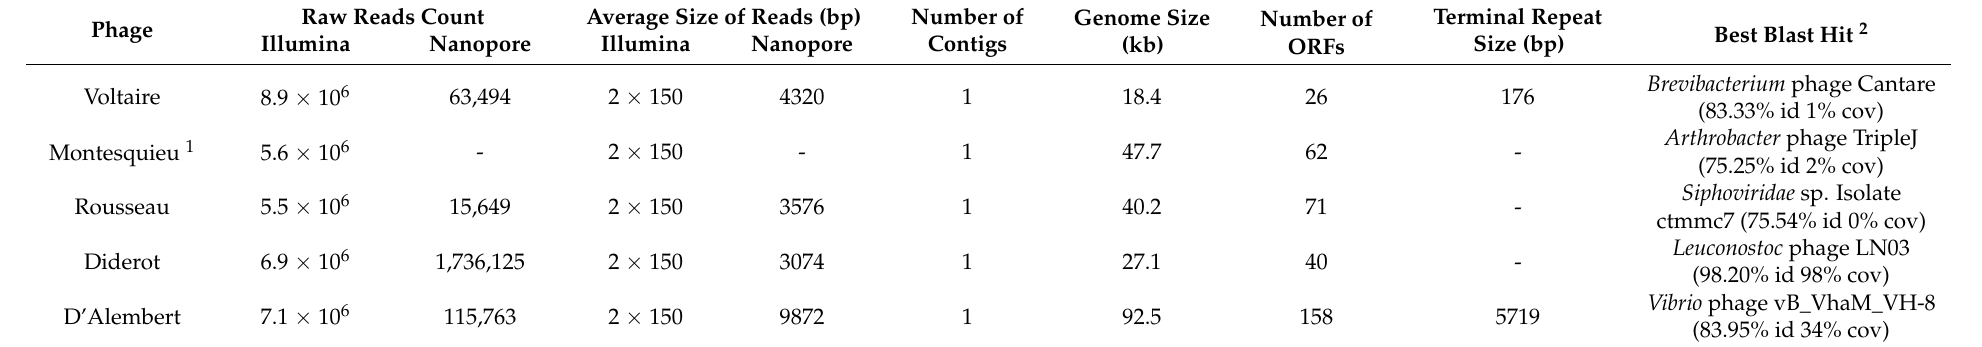
Table 5. Global metrics around sequencing and assembly